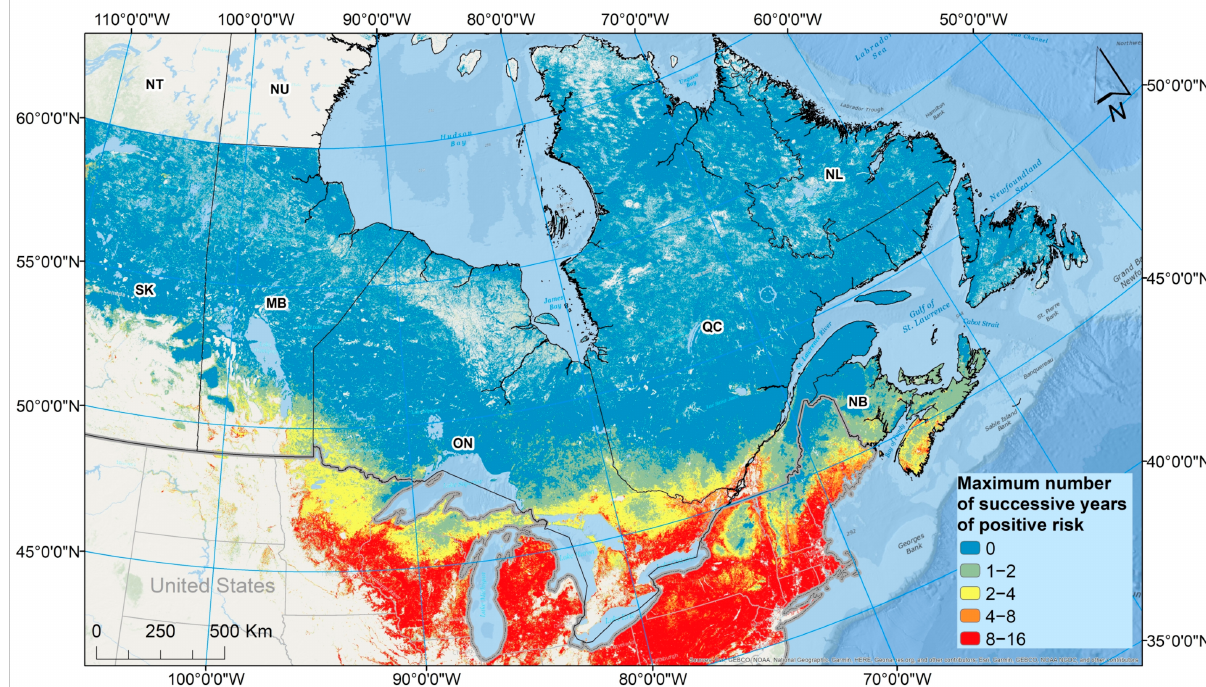
Figure 11. Maximum successive years of positive risk of Ixodes scapularis (RIS) in Central and Eastern Canada from 2000 to